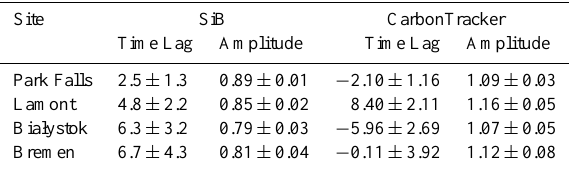
Table 3. Time lag and amplitude adjustments necessary to best fit the TCCON data with the model fits. The time lag is in days, where a positive time lag means that the model should be delayed to best fit the TCCON data. The amplitude is multiplicative, so a value less than 1 means that the model amplitude should be reduced to best fit the TCCON data. See Fig. 3 for the related figure.